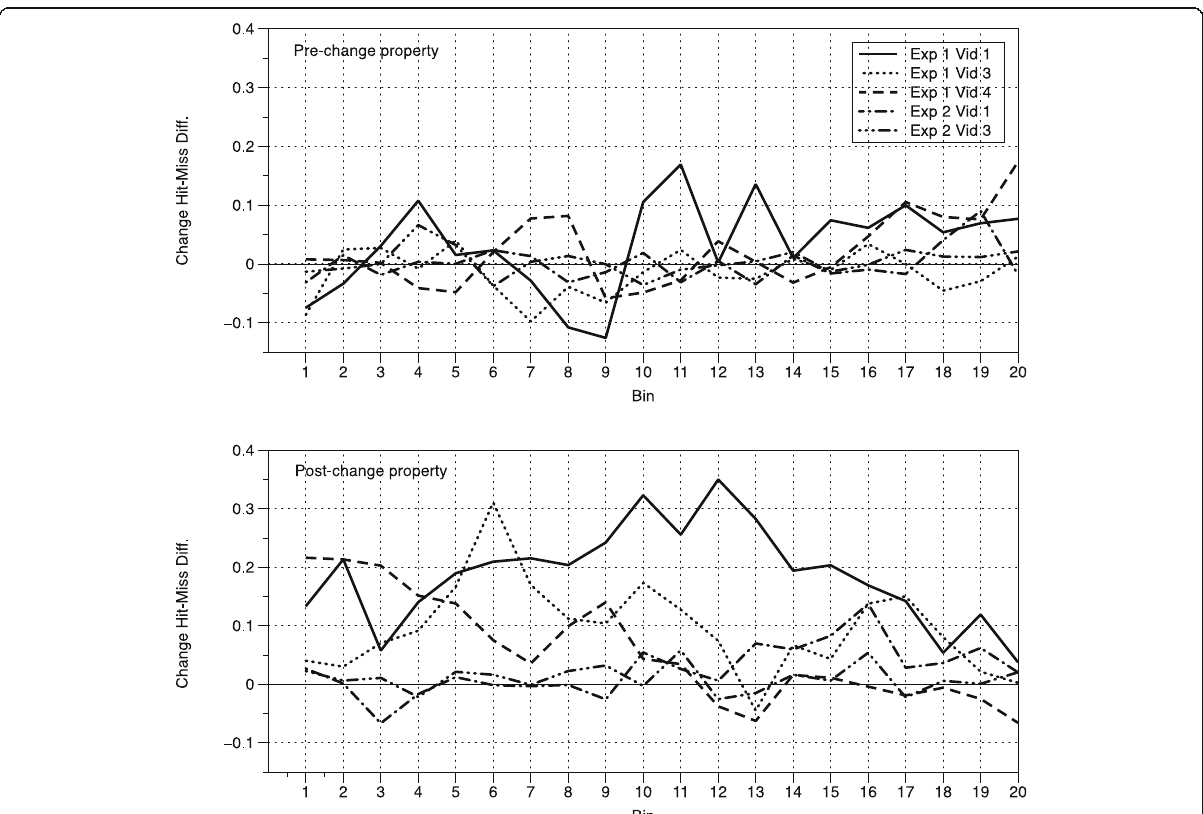
Fig. 3 Difference in fixation probability between participants who did and did not detect the change, across time bins in pre- and post-change property regions of interest. Positive values indicate extent to which participants who detected the change looked at the property longer than participants who missed the